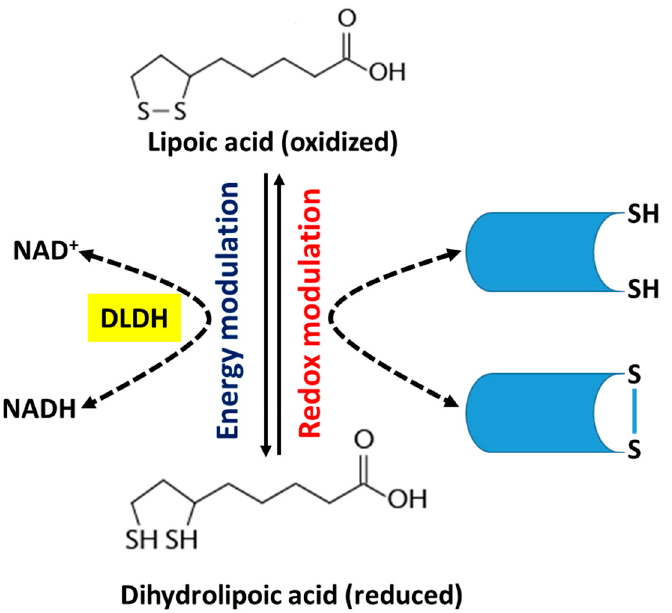
Figure 3. Lipoic acid is involved in thiol-disulfide exchanges that modulate cell’s redox and energy status.